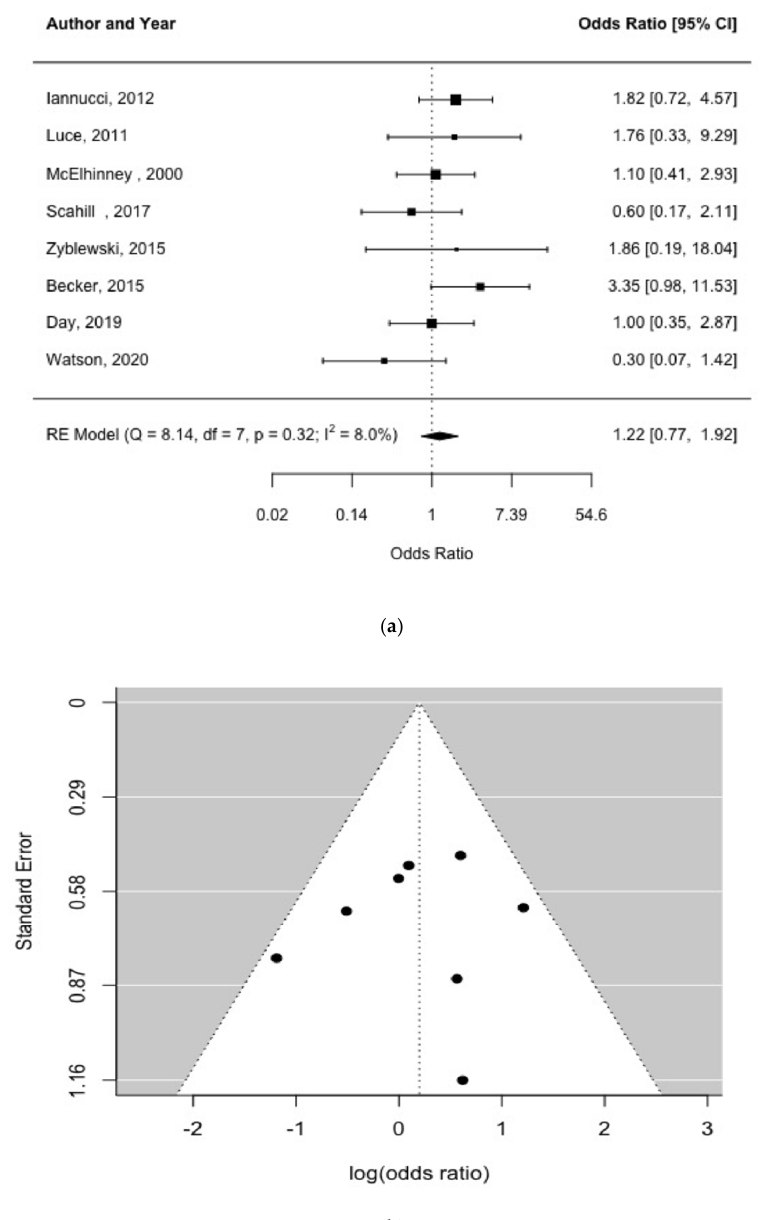
Figure 2. Forest plot ( a ) and funnel plot ( b ) of study effect estimates for preoperative feeding and NEC [shown as odds ratios and log (odds ratios), respectively] [5,21–27]. Egger’s test did not indicate funnel plot asymmetry [ p =